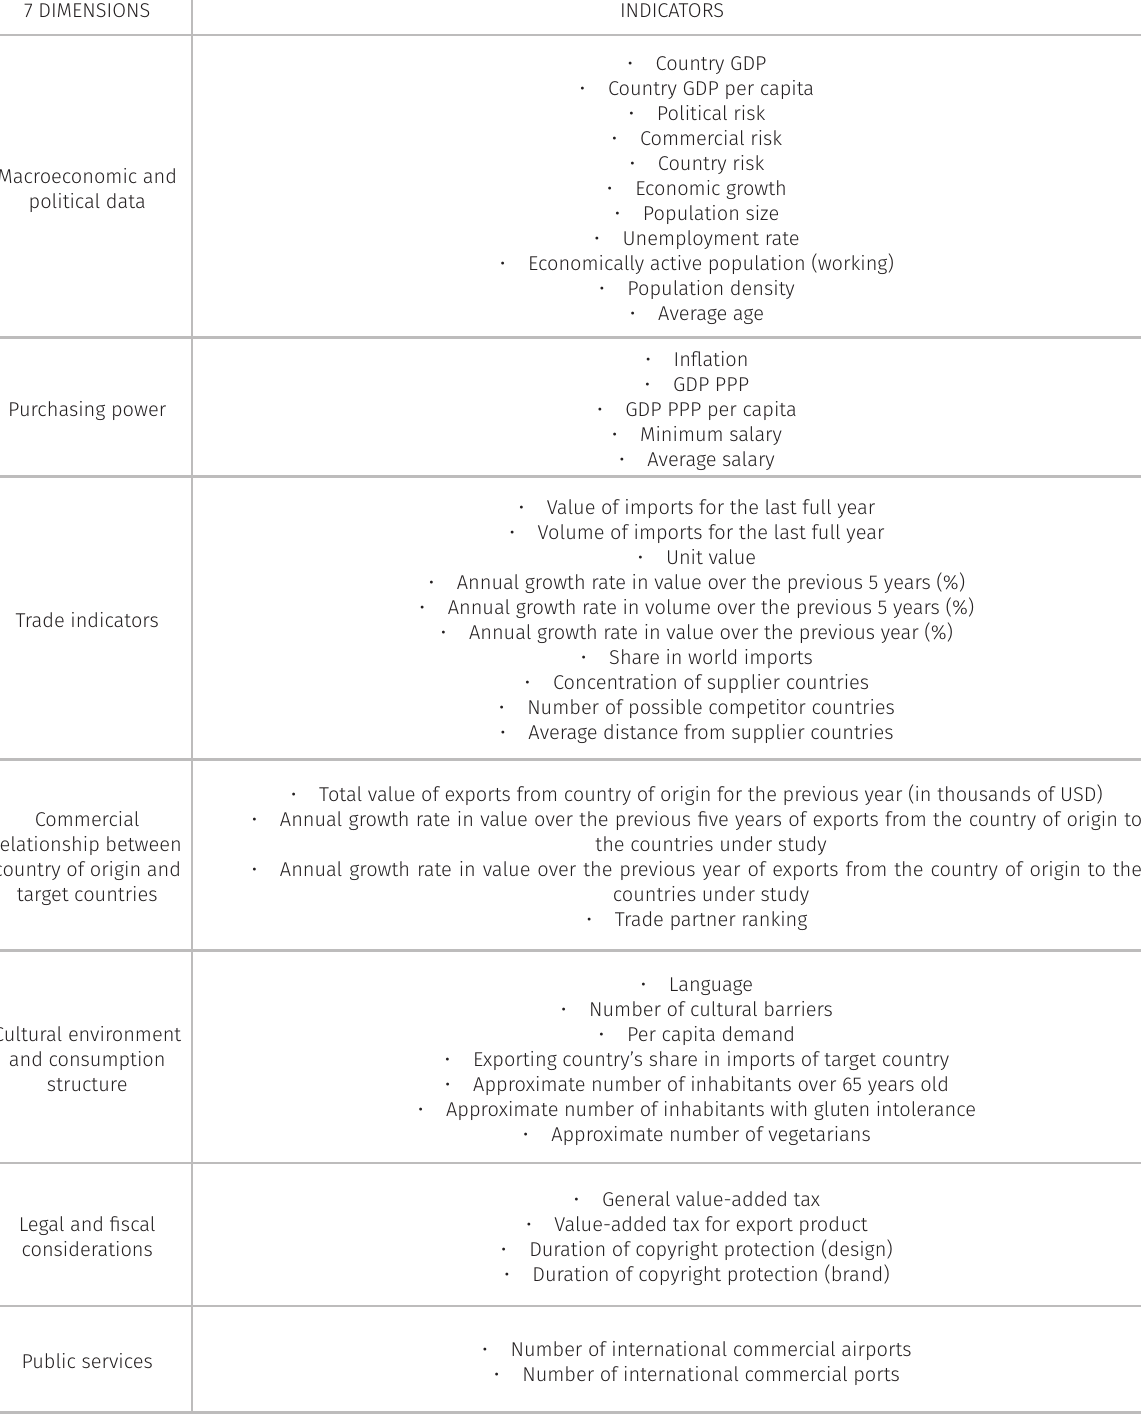
Table V. 7 dimensions and indicators used in the model during the market selection